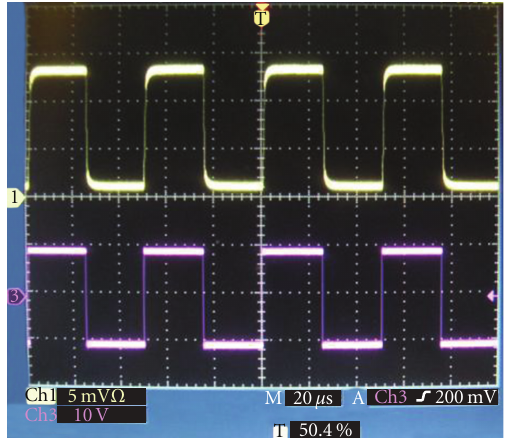
Figure 5: 1.5- μ m optical output signal after polarizer with the angular di ff erence between transmitter and receiver of 45 ◦ < | Δ θ | < 135 ◦ . (a) The 1.5- μ m optical output signal after the polarizer and (b) the applied voltage (20:1) for the polarization modulator are shown as Ch1 and Ch3 with the modulated frequency of 20kHz.